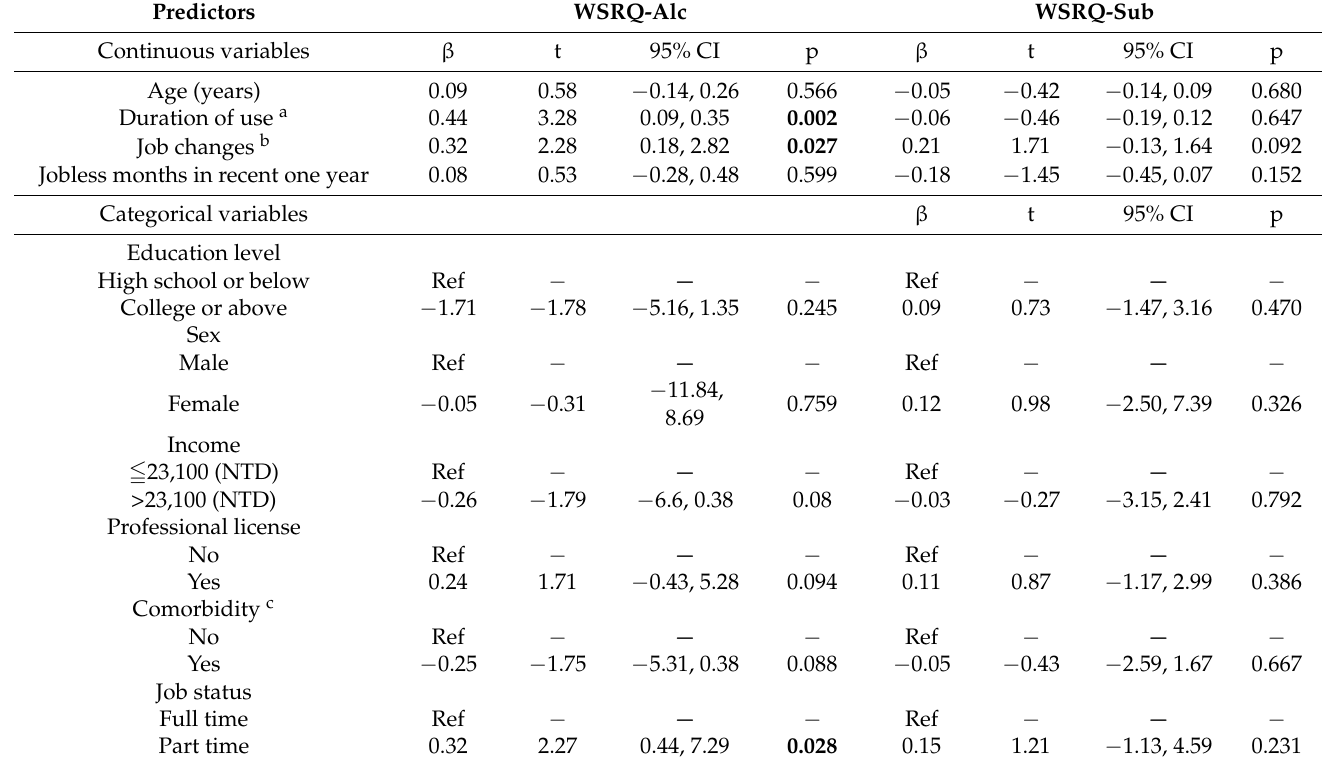
Table 4. Predictors of Workplace Substance Reuse Questionnaire examined by multivariate linear